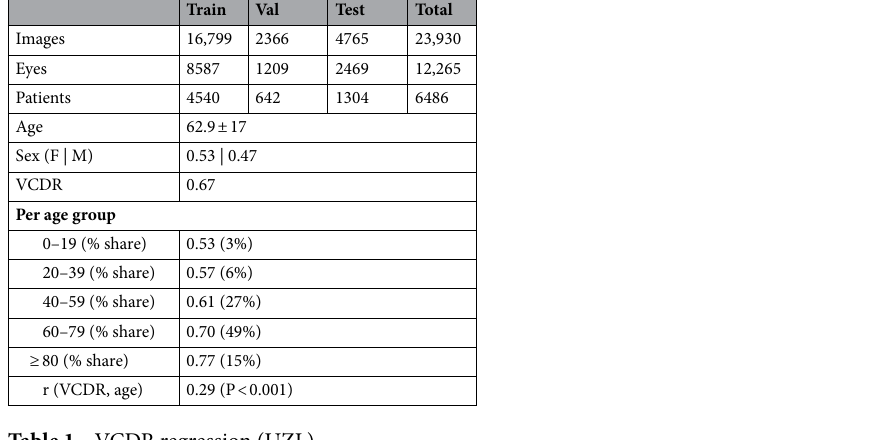
Table 1. VCDR regression